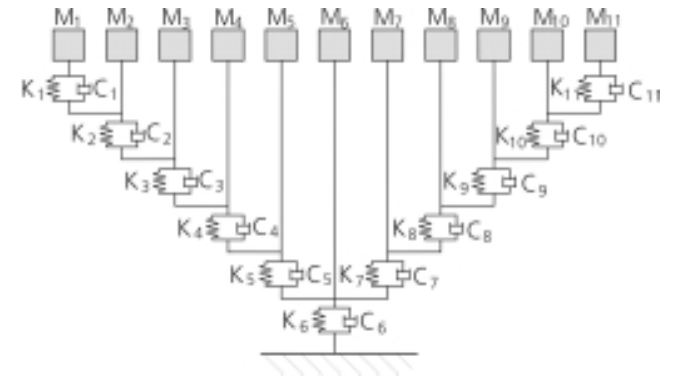
Fig. 2. Analytical vibration system with 11